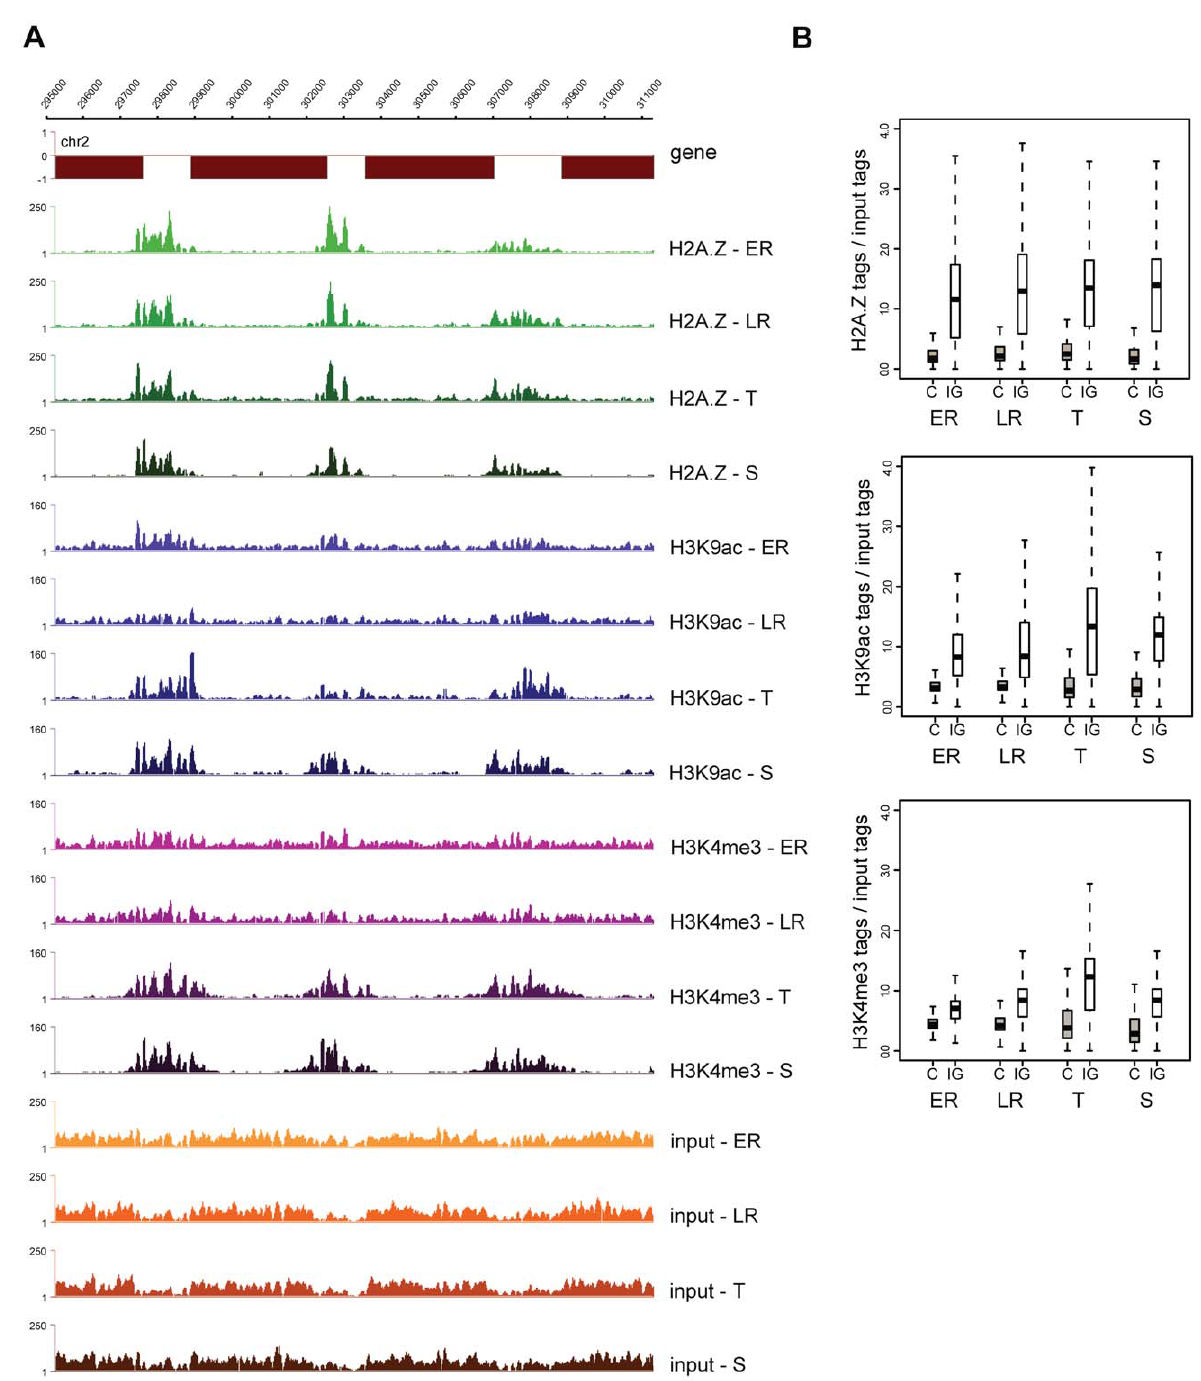
Figure 3. H2A.Z occupancy is invariable, while H3K9ac and H3K4me3 marking is dynamic through the intraerythrocytic cycle. ( A ) Screenshots of the H2A.Z, H3K9ac and H3K4me3 ChIP-seq and mono-nucleosomal input coverage plots at four stages of intraerythrocytic development (ER: early ring; LR: late ring; T: trophozoite; S: schizont) ( B ) Box-plot displaying the ratios of ChIP’ed vs mono-nucleosomal input DNA tag counts in every coding and intergenic region of the P. falciparum genome at four stages of intraerythrocytic development.